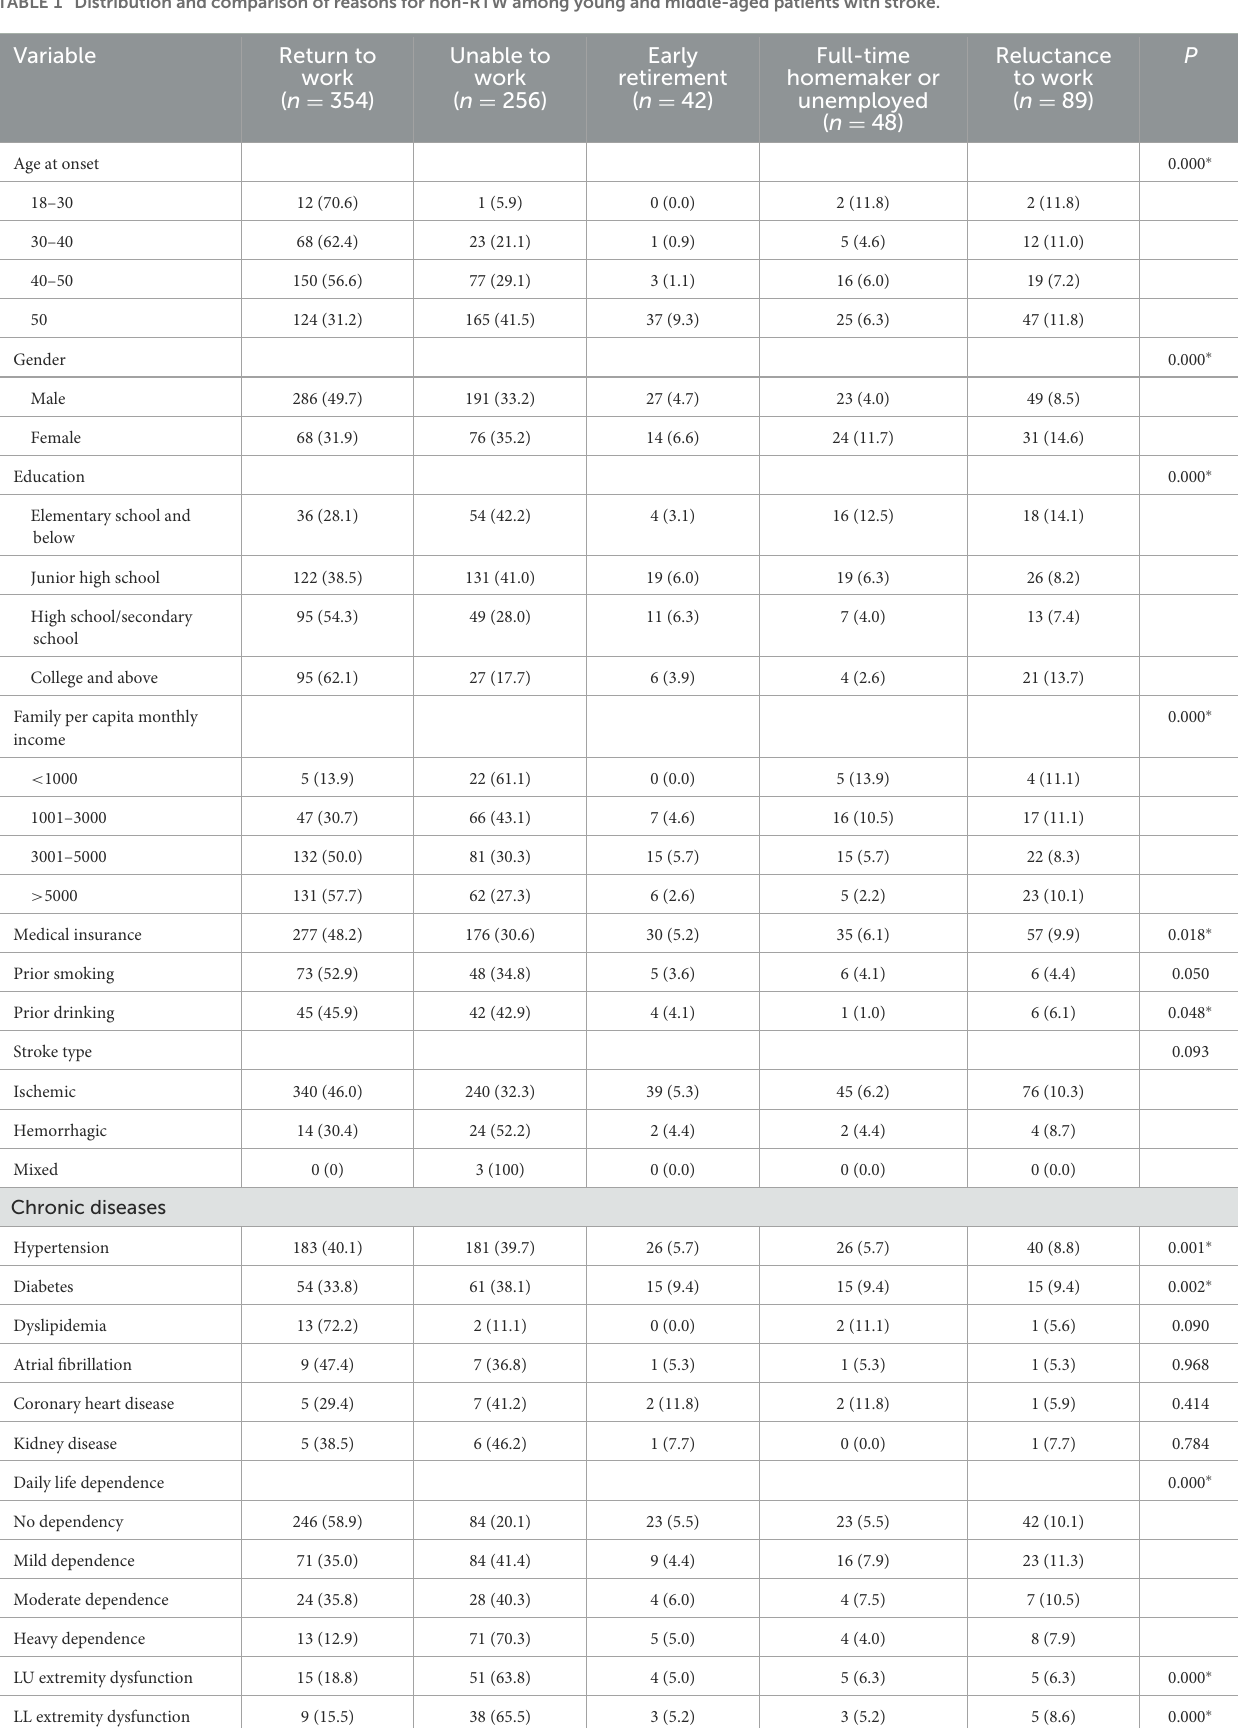
TABLE 1 Distribution and comparison of reasons for non-RTW among young and middle-aged patients with stroke.